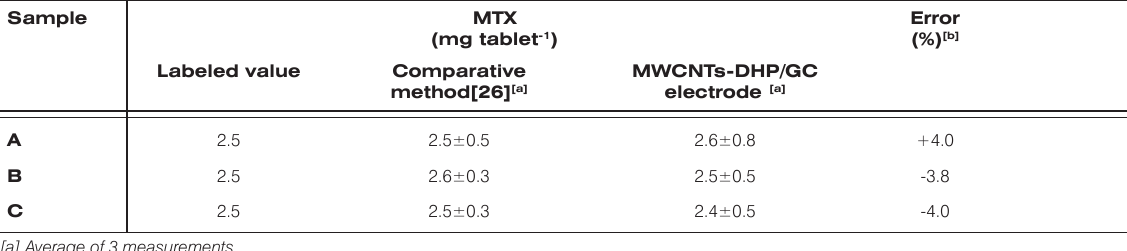
Table 1. Determination of MTX in pharmaceutical formulations.